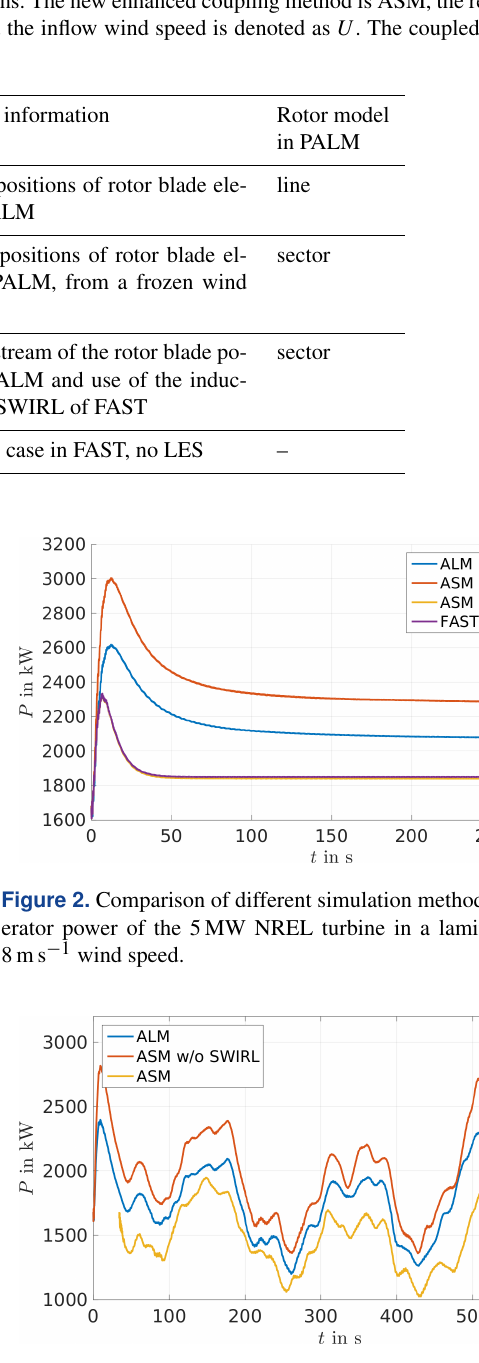
Figure 3. Comparison of different simulation methods for the gen- erator power of the 5MW NREL turbine in a turbulent flow at about 7.4ms − 1 wind speed at hub